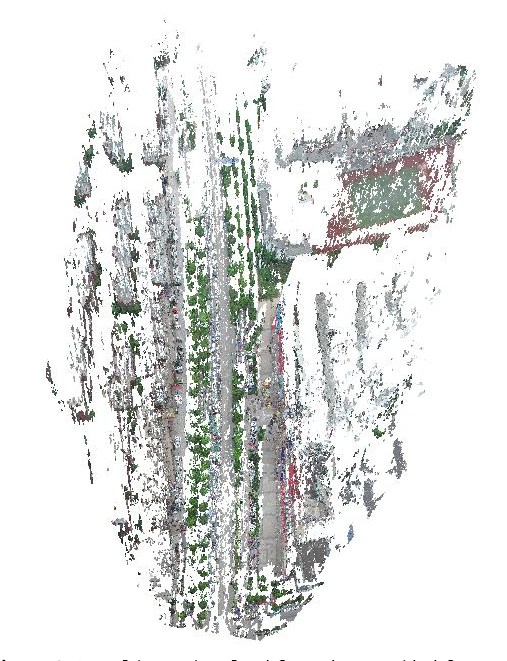
Figure 2. Resulting point cloud from the provided frames of “seq18”.